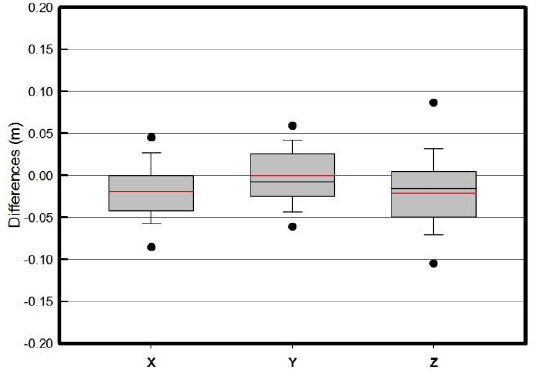
Figure 8. Differences between CTP-Trimble® PIVOT™ and RTX solutions, for the components of position